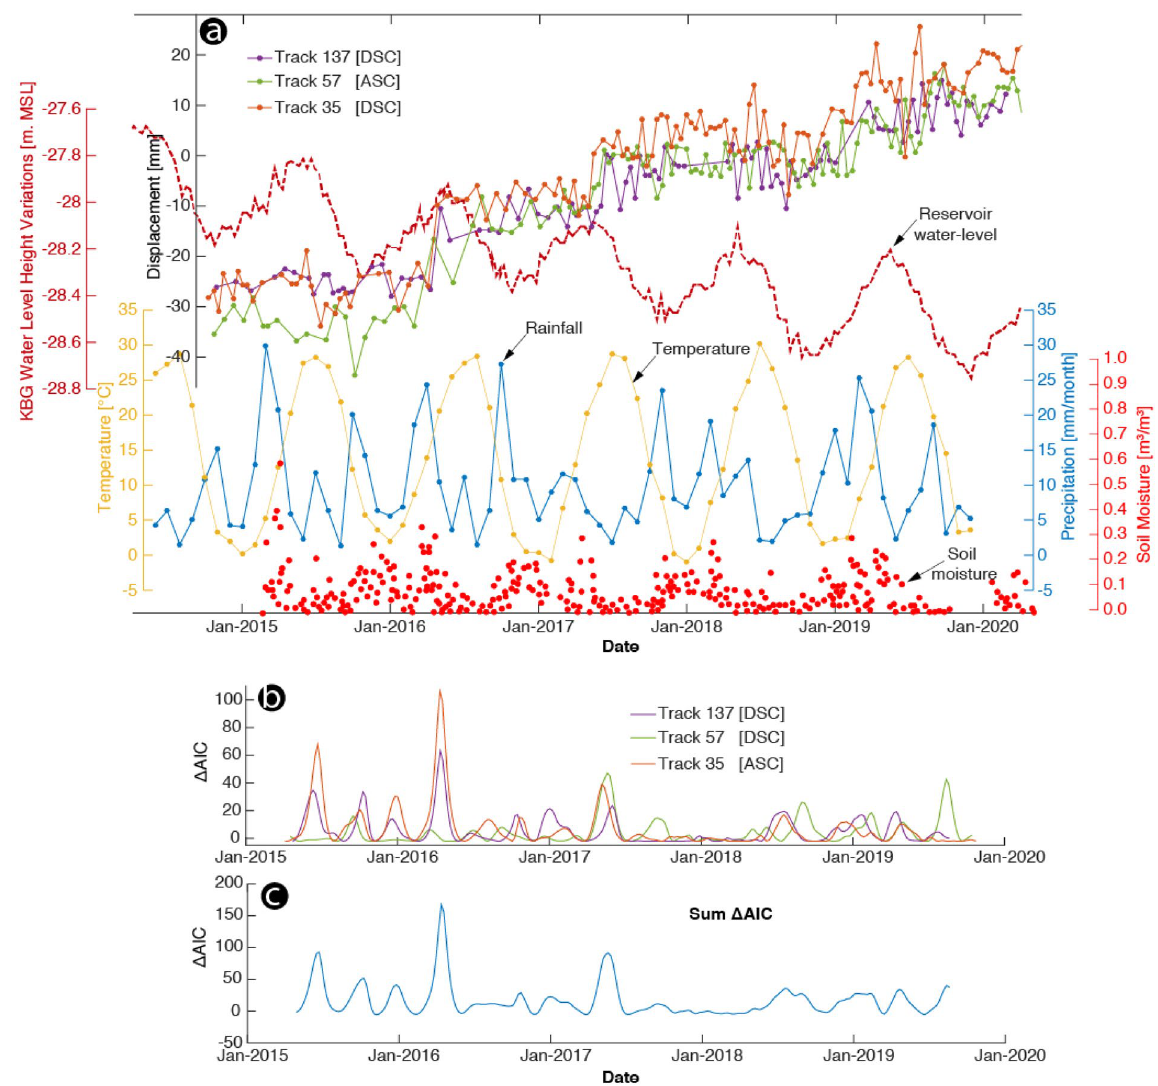
Figure 4. Landslide motion estimated from Sentinel-1 ascending track 57 (green) and descending tracks 137 (purple) and 35 (orange) used in the InSAR time series analysis compared with hydrological and atmospheric parameters derived from multiple satellite sensors. ( a ) InSAR-derived multi-annual landslide motion with week- long transient accelerating burst-like creep events, KBG lake water level height variations in meters above mean sea level (burgundy), temperature (°C; yellow), precipitation (mm/month; blue), and soil moisture (m 3 /m 3 ; red). Velocity time series were projected onto the horizontal direction for better comparison. ( b ) ΔAIC between linear landslide sliding rate models with and without transient acceleration events computed for each track independently. (cid:31) AIC is positive when the transient model is preferred. ( d ) Summation of all (cid:31) AIC highlighting one major transient event. This figure was created with MATLAB (R2011a). (https:// www. mathw orks. com/ produ cts/ matlab. the reservoir in a very regular fashion that resulted in a stair-step topography. The proposed mechanism consists of the break-down of blocks of competent limestone that lose adhesion to the main limestone layer covering the Ustyurt plateau and rotates over the weak clays-rich layers. In this study, we highlighted transient episodes of motion superposed to a constant creep. Analysis of remotely sensed SAR data acquired from multi-viewing geometries and PSI data allowed us to extract both horizontal and vertical motions of the slowly moving giant landslide. To characterize the kinemat- ics of this mega landslide, we compared the multi-annual time series of InSAR data with the time series of key factors that control the hydrological forces in the study area, such as the water level in the KBG reservoir, soil moisture, temperature, and rainfall. Our results suggest that such an immense mass movement is not currently stable; rather, seasonally significant acceleration occurs annually in accordance with the maximum water level of the KBG reservoir and soil moisture. The strong correlation between the mega landslide movement episodes and the reservoir water level shows its sensitivity to present-day hydrological forcing. This indicates a strong